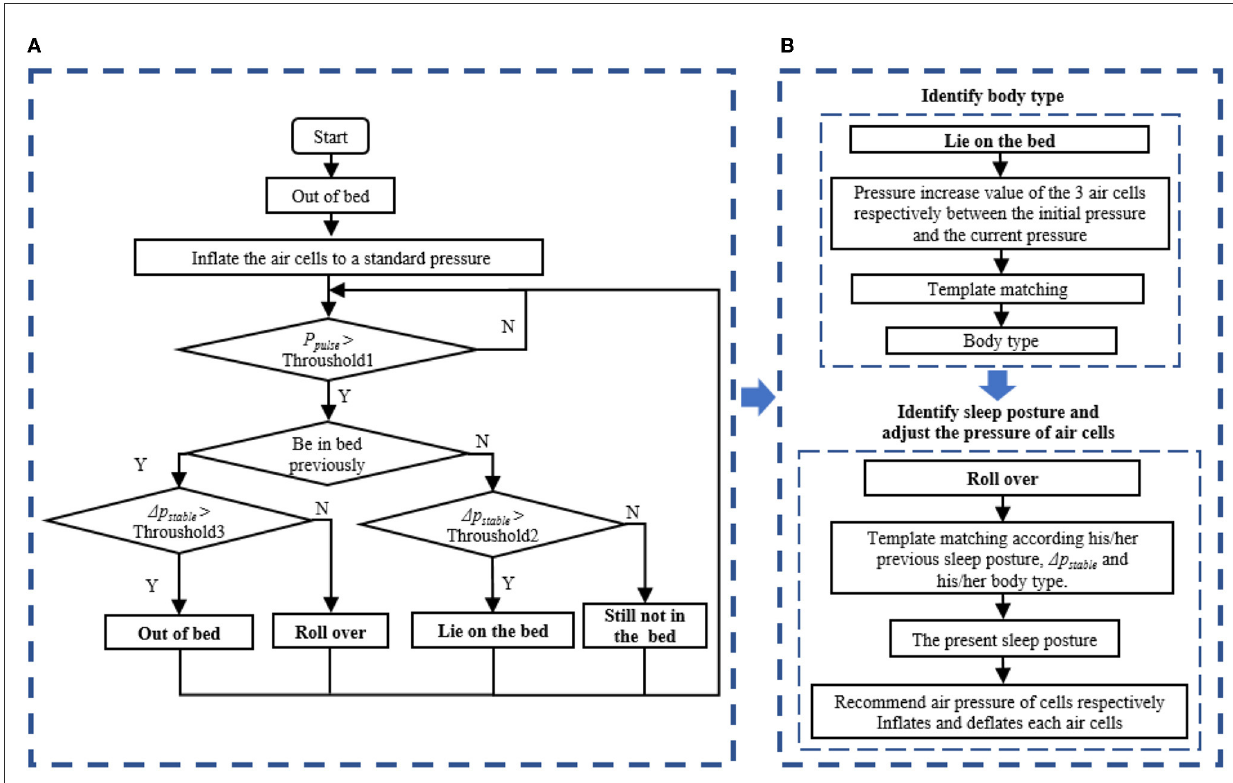
FIGURE2 Schematic diagram of the control strategy. (A) Determine whether anyone is in bed and whether occurs a rolling action. (B) The process of pressure-adjusting when someone is in mattress and roll over is detected.